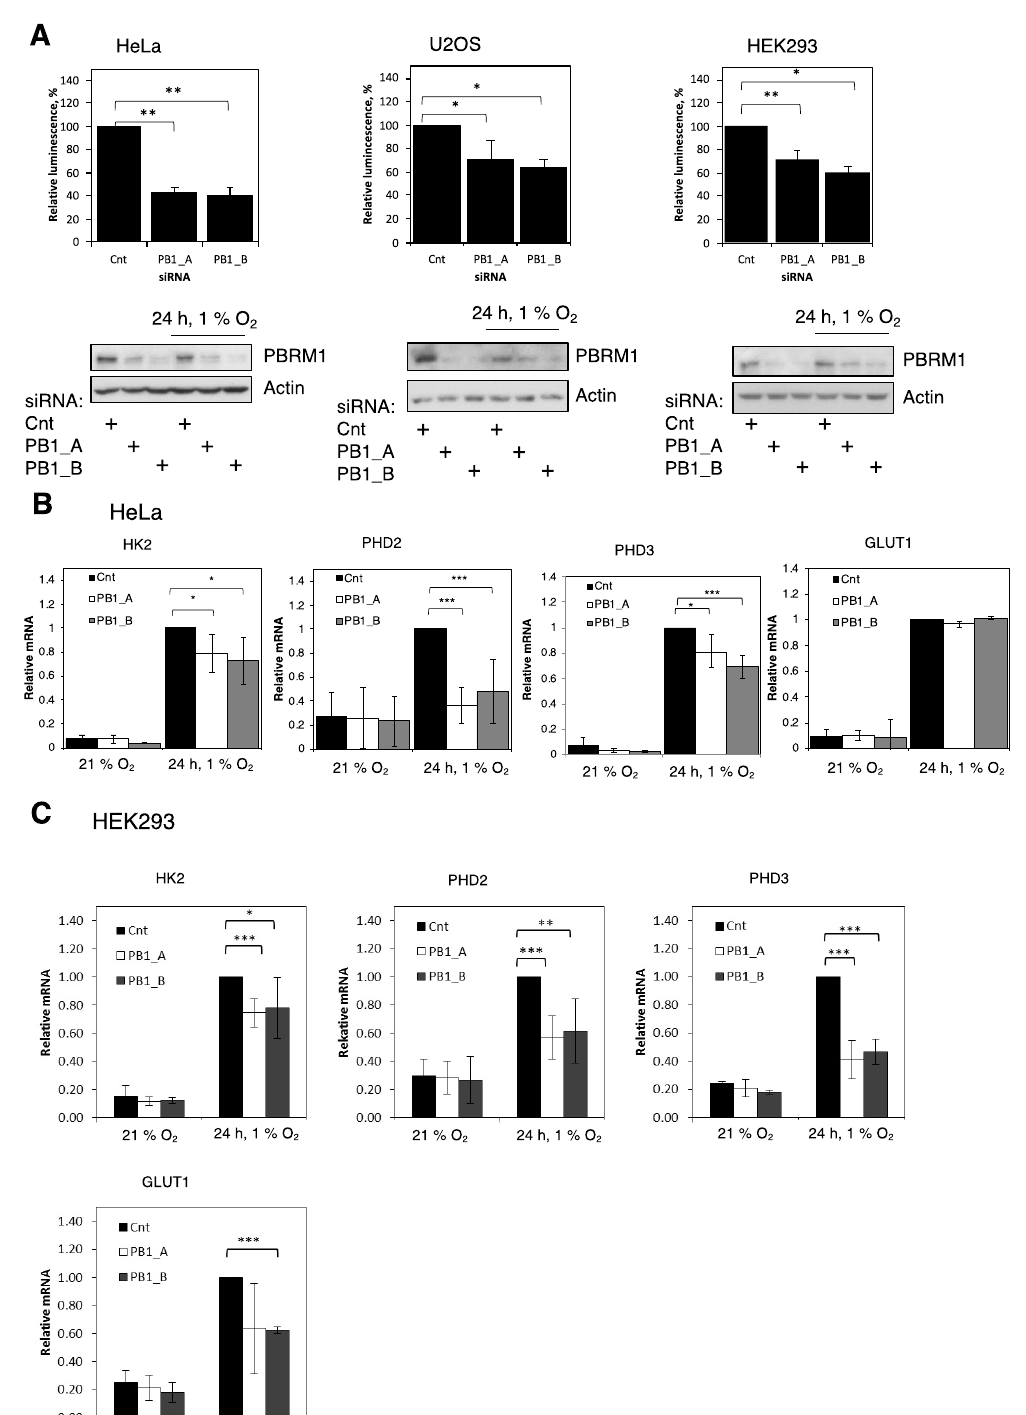
Figure 1. PBRM1 is required for HIF transcriptional activity. ( A ) The HeLa, U2OS and HEK293 HRE-luciferase reporter cell lines were transfected with either control (Cnt) or PBRM1 (PB1) siRNAs for 48 h prior to lysis and exposed to 1% O 2 for 24 h prior to lysis. Cell lysates were assayed for luciferase activity and Western-blotted. The graphs display the means and standard deviations (SD) of a minimum of three independent biological replicates with ANOVA significance indicated (* p ≤ 0.05, ** p ≤ 0.01). +, signifies specific treatment. ( B ) The HeLa cells and ( C ) the HEK293 cells were transfected and treated with hypoxia as before. Total RNA was extracted, and mRNA levels were assessed by qPCR, normalised to actin and compared to control siRNA. The graphs depict the means and SD of a minimum of three independent biological replicates with ANOVA significance indicated (* p ≤ 0.05, ** p ≤ 0.01. *** p ≤